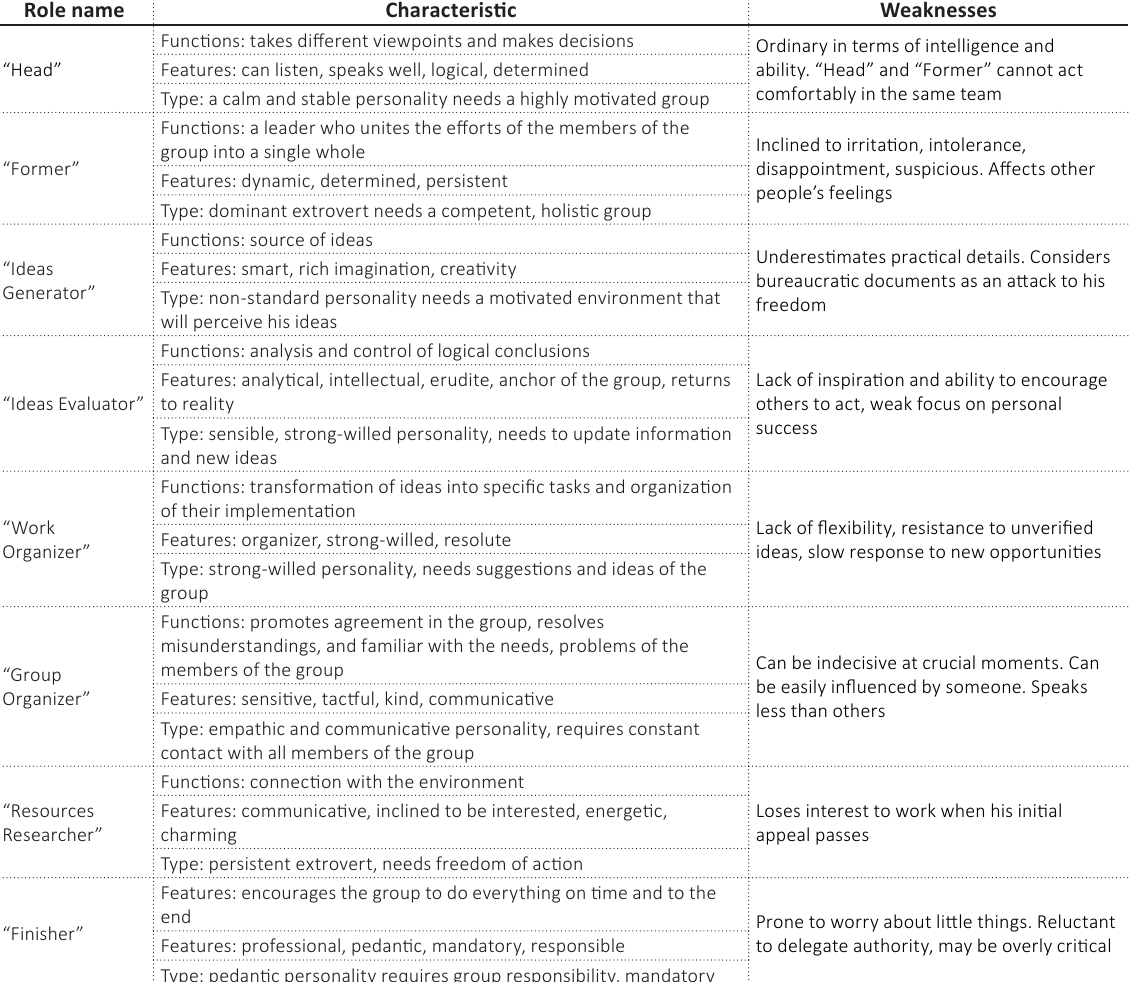
Table 3. Characteristics of team roles